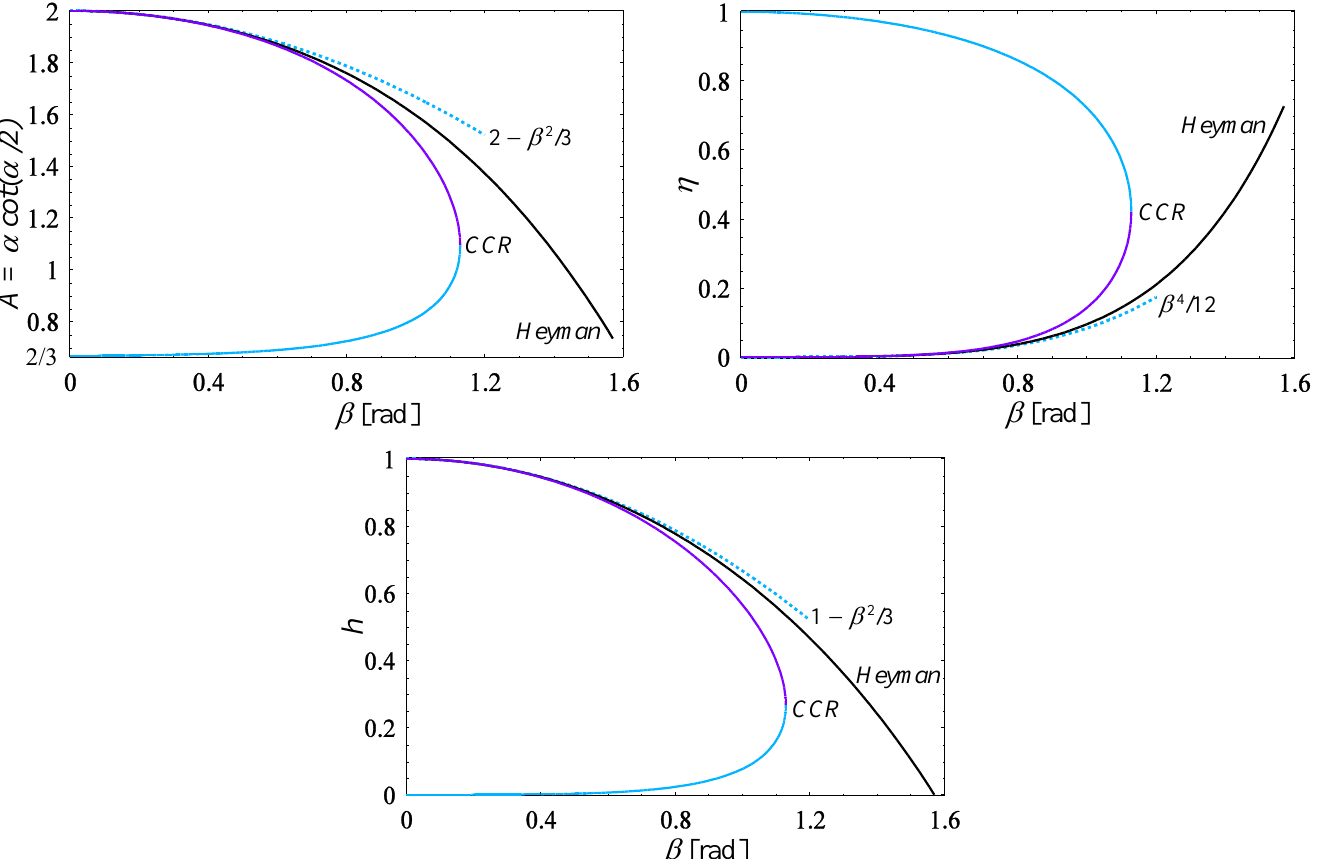
Figure 2: Analytical parametric plot of solution triplet A (  ),  (  ), h (  ) as a function of inner hinge angular position  for CCR and Heyman solutions, with common trends for small  ( A =  cot(  /2),  : half-angle of embrace;  : thickness to radius ratio; h : non- dimensional horizontal thrust; refer to Fig.